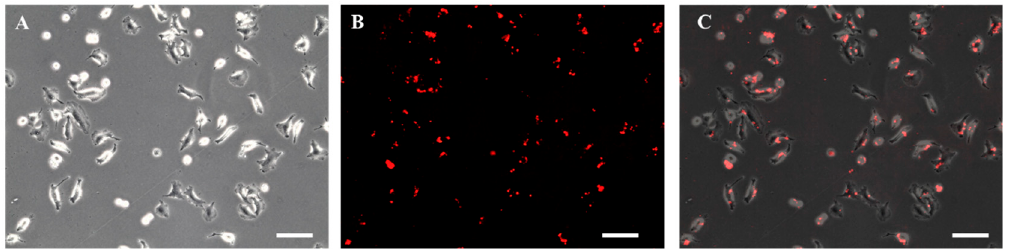
Figure 5. Photomicrographic images of A549 cells treated with 0.02 mg/mL biotin-X DHPE followed by the treatment of streptavidin labeled with PE-Cy5.5 for 24 h: ( A ) phase-contrast, ( B ) fluorescence, and ( C ) overlay image (scale bar = 100 µm).